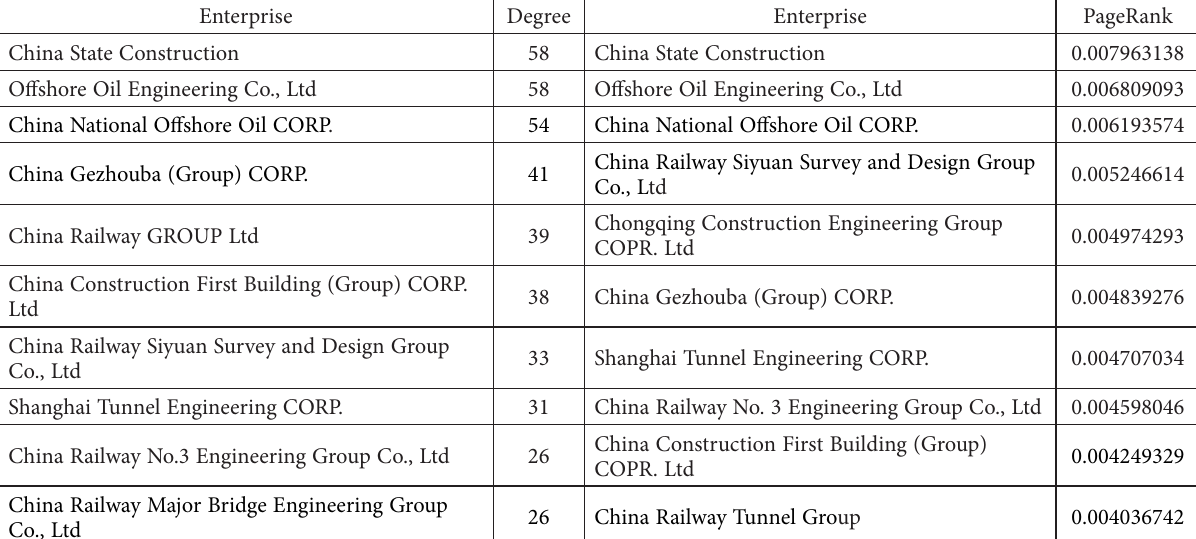
Table 3. Top 10 enterprises applying for patents with high Degree and